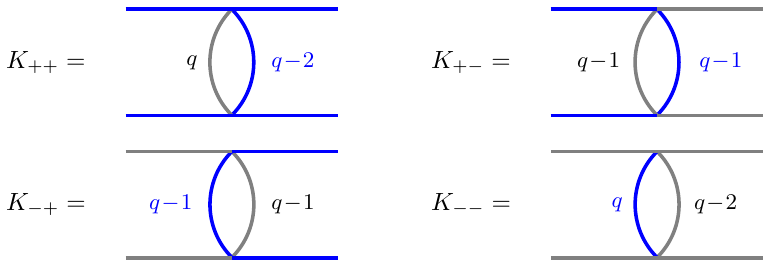
Figure 3 . Diagrammatic de(cid:12)nition of the kernel that gives the four-fermion correlation function. Here each line represents multiple dressed propagators, with multiplicity as